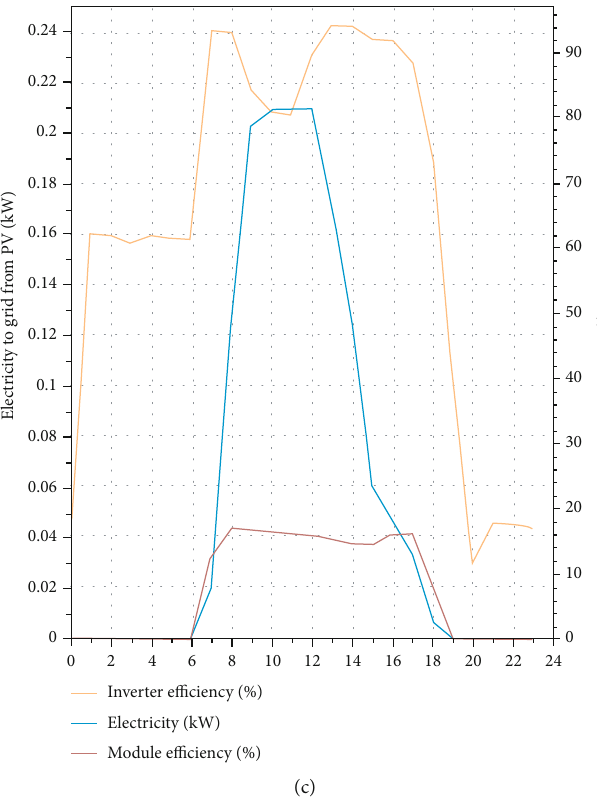
Figure 4: (a) System losses. (b) PV energy Sankey diagram. (c) Annual PV module and inverter e ffi ciency. Metric